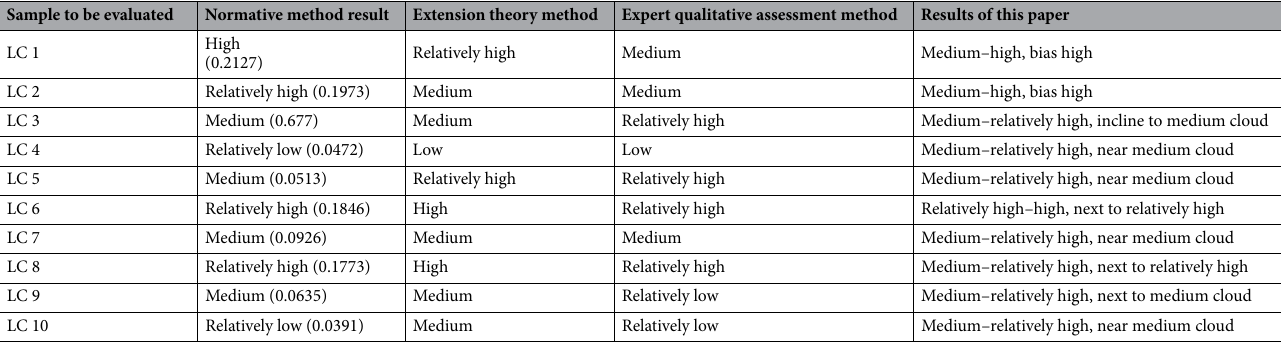
Table 7. Comparison of risk assessment results of the No. 1–10 loess collapsibility of